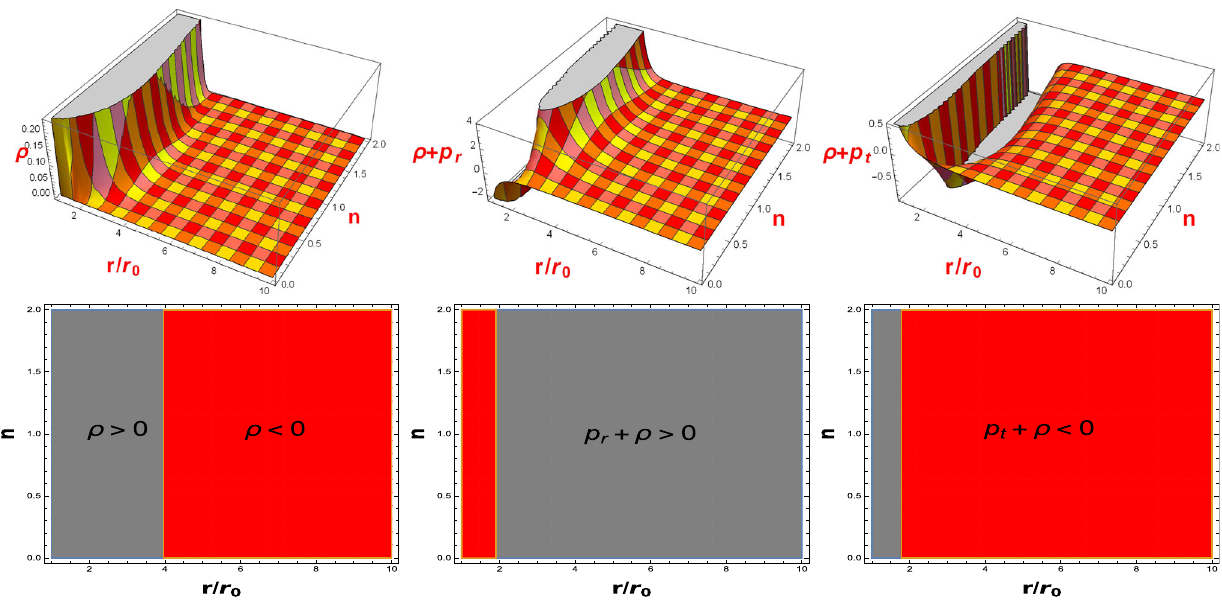
> 0 and ρ + p < 0. r t